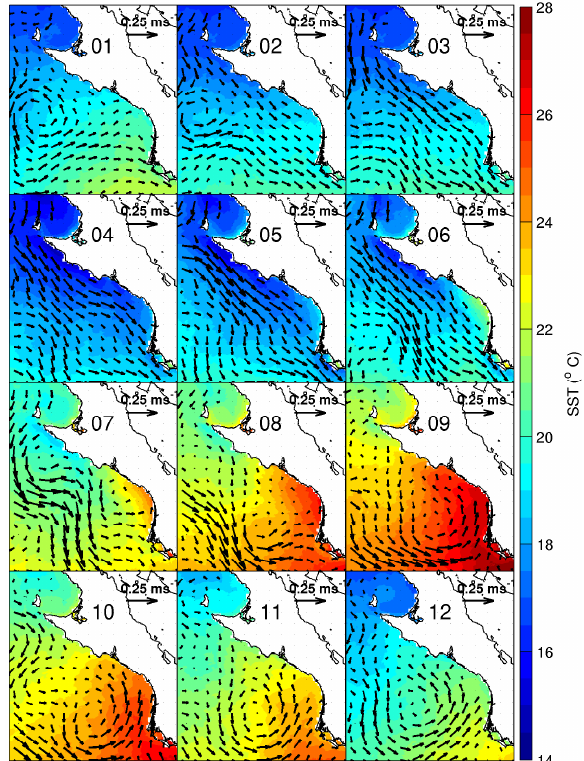
Fig. 4. Maps of monthly mean sea surface temperature (SST) and geostrophic currents for 2003–2007. Numbers in each panel indi- cate the month of the year.